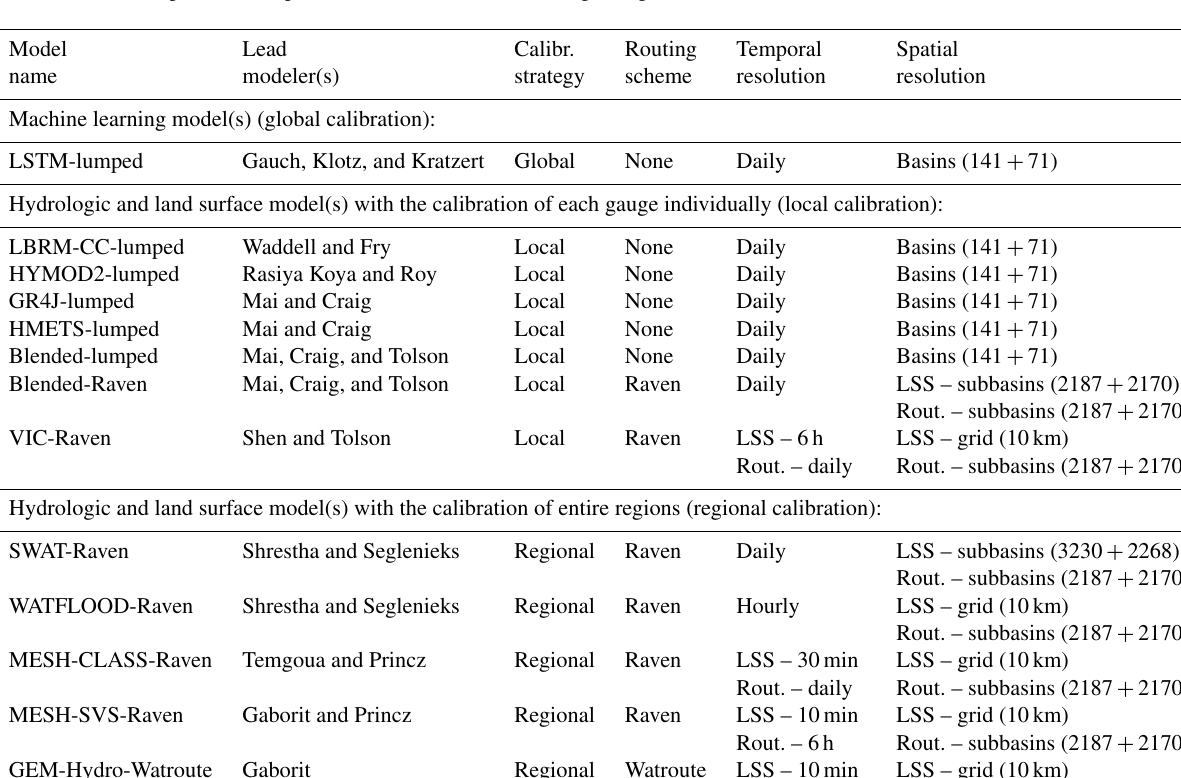
Table 1. List of participating models. The table lists the participating models and the lead modelers responsible for model setups, calibration, and validation runs. The models are separated into three groups (see headings in the table), namely machine learning (ML) models which are all globally calibrated, hydrologic models that are calibrated at each gauge (local calibration), and models that are trained for each region, such as the Lake Erie or Lake Ontario watershed (regional calibration). Note that the temporal and spatial resolution of the fluxes of the land surface scheme (LSS) can be different from the resolutions used in the routing (Rout.) component. All LSS grids are set to the RDRS-v2 meteorological data forcing grid of around 10km by 10km. The two numbers given in the column specifying the spatial resolution (XXX + YYY) correspond to the spatial resolution of the models regarding calibration basins (XXX) and validation basins (YYY). Model Lead